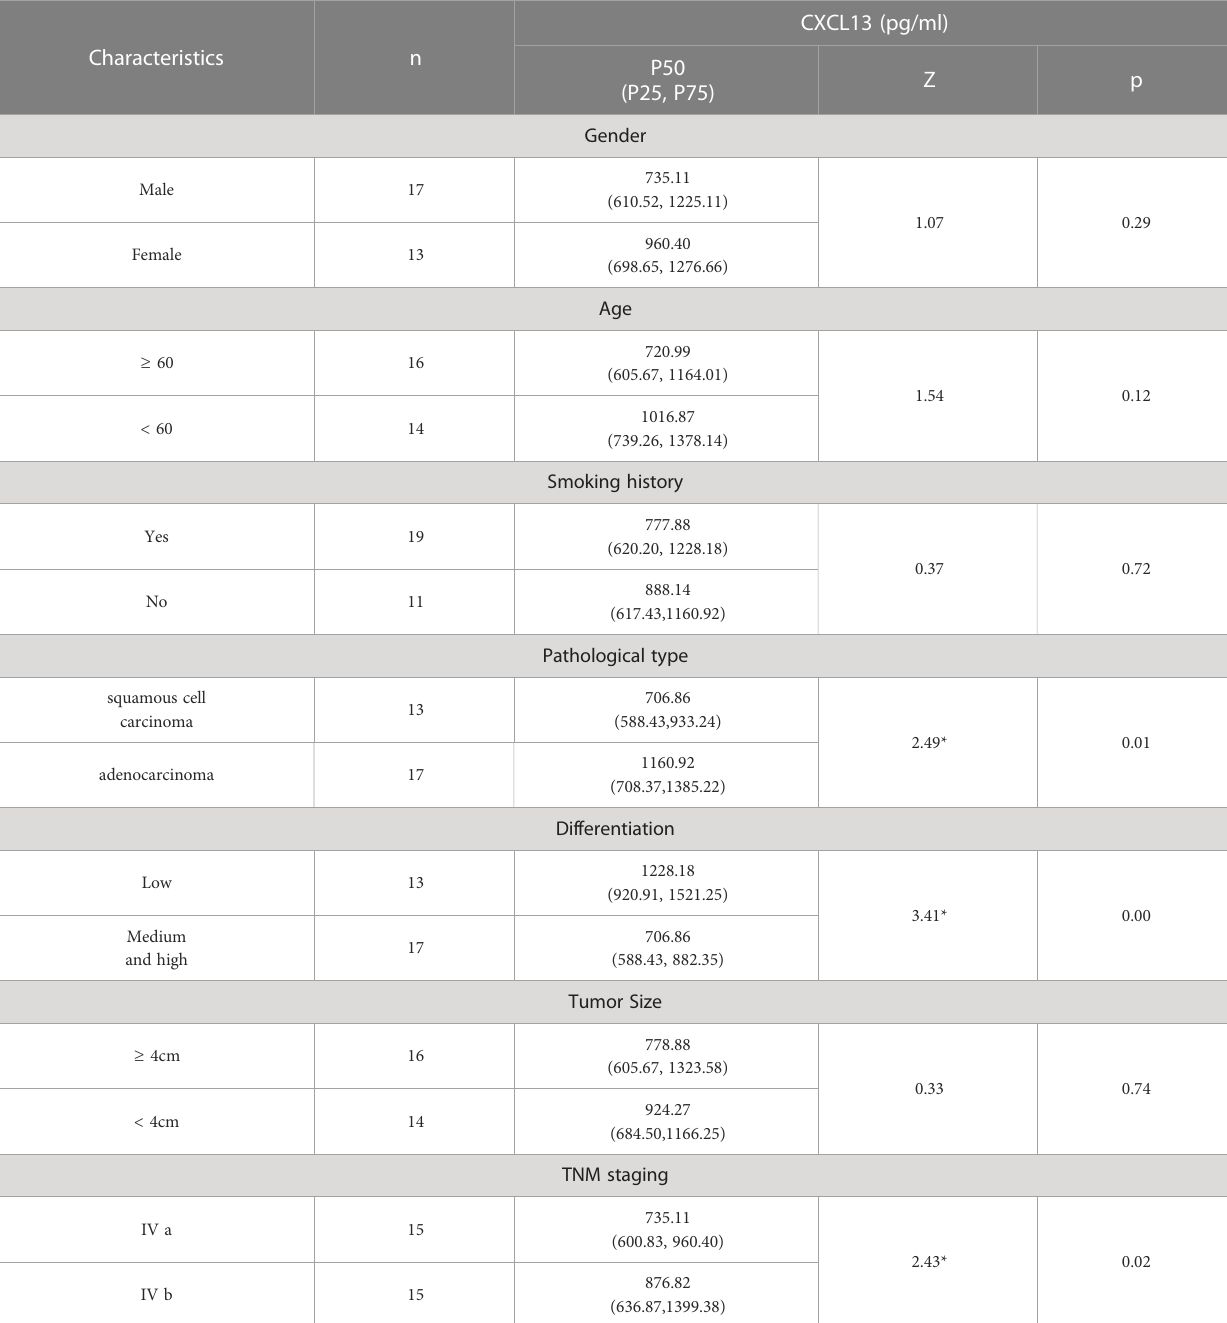
TABLE 3 The correlation between the relative expression level of CXCL13 and various clinical characteristics in the NSCLC group.